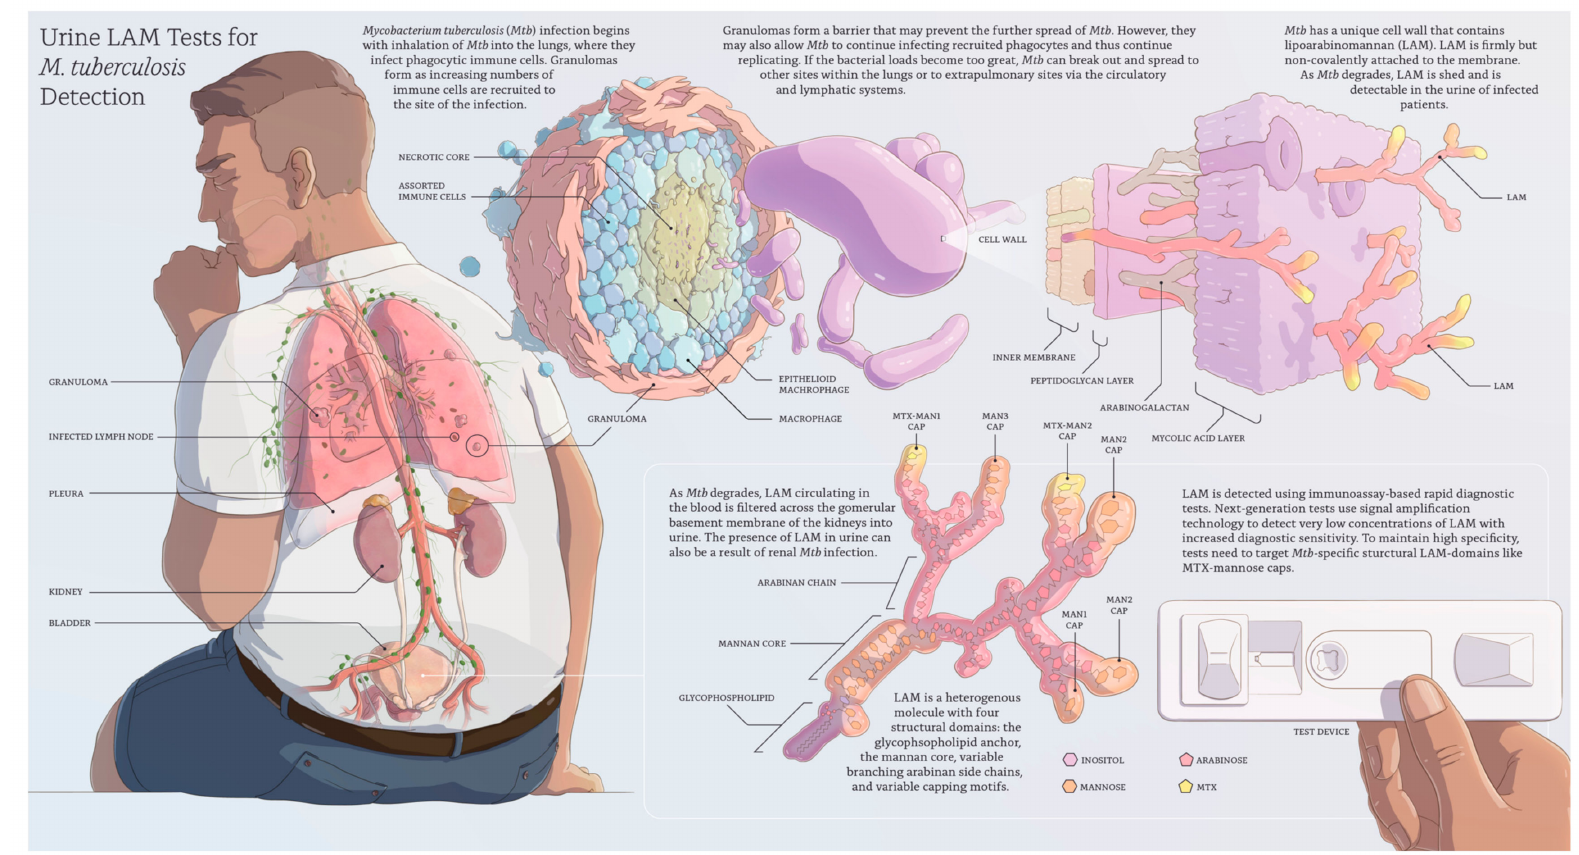
Figure 1. Overview of lipoarabinomannan (LAM) detection in urine for the diagnosis of active tuberculosis (developed by Digizyme, Inc., Boston, MA, USA and FIND, Geneva,